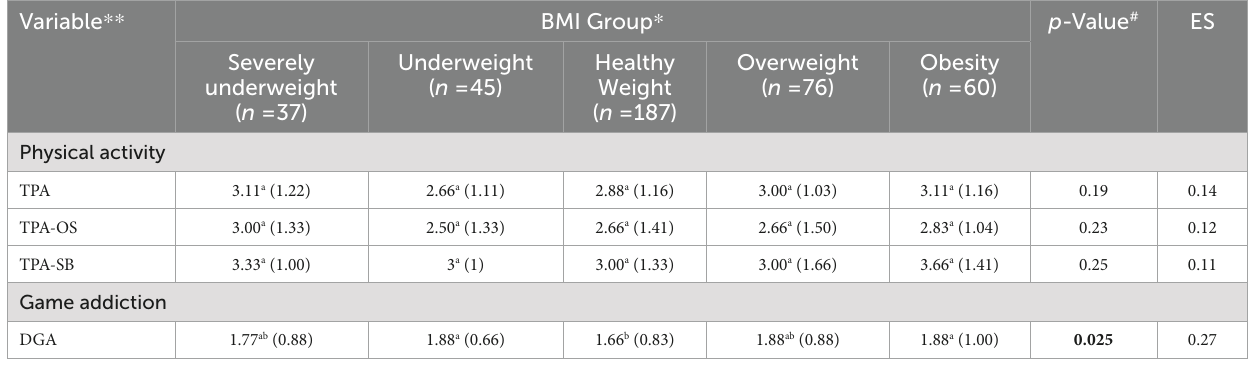
TABLE 4 Changes in BMI groups for physical activity and DGA scores.